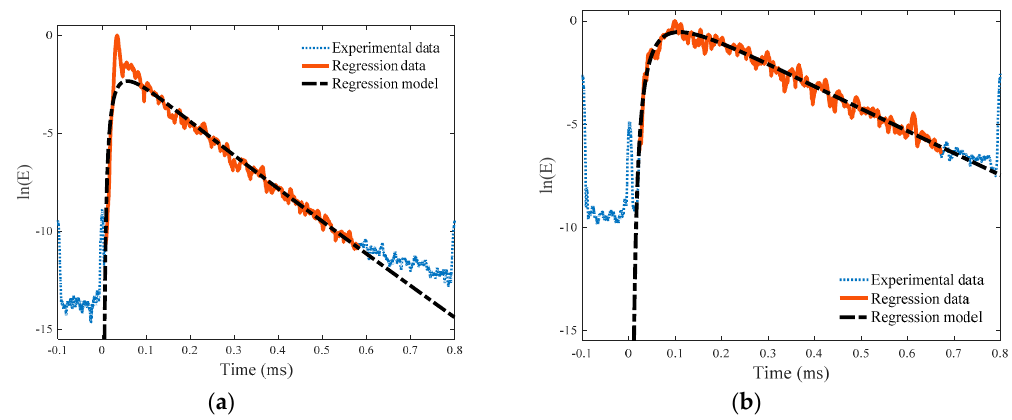
Figure 7. Ultrasonic spectral energy density after spatial averaging: ( a ) No crack; ( b ) 0.01 mm width crack.